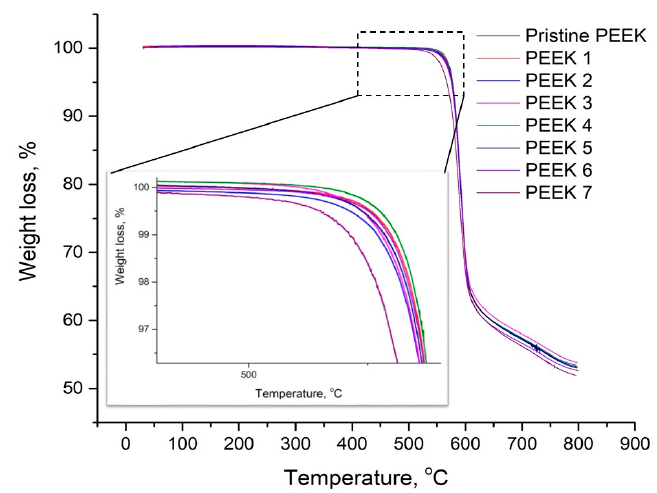
Figure 7. TGA curves of the pristine and irradiated PEEK samples.